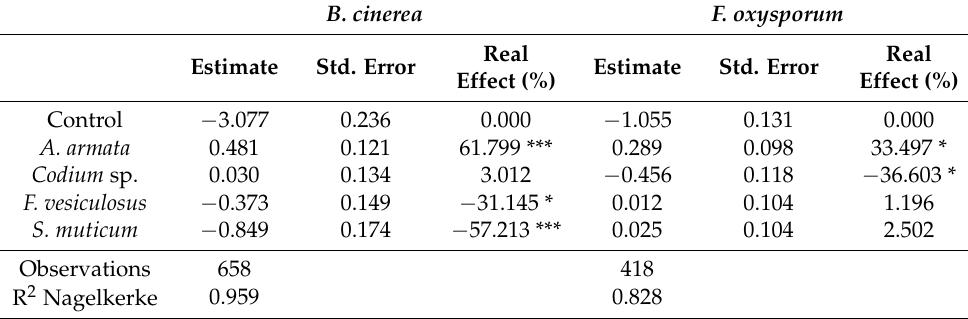
Observations R 2